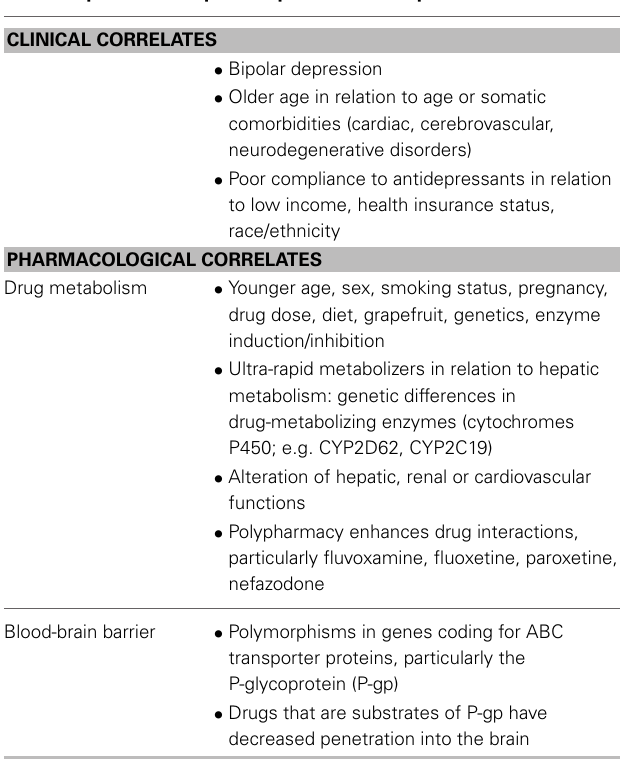
Table 1 | Mechanisms predicting response to